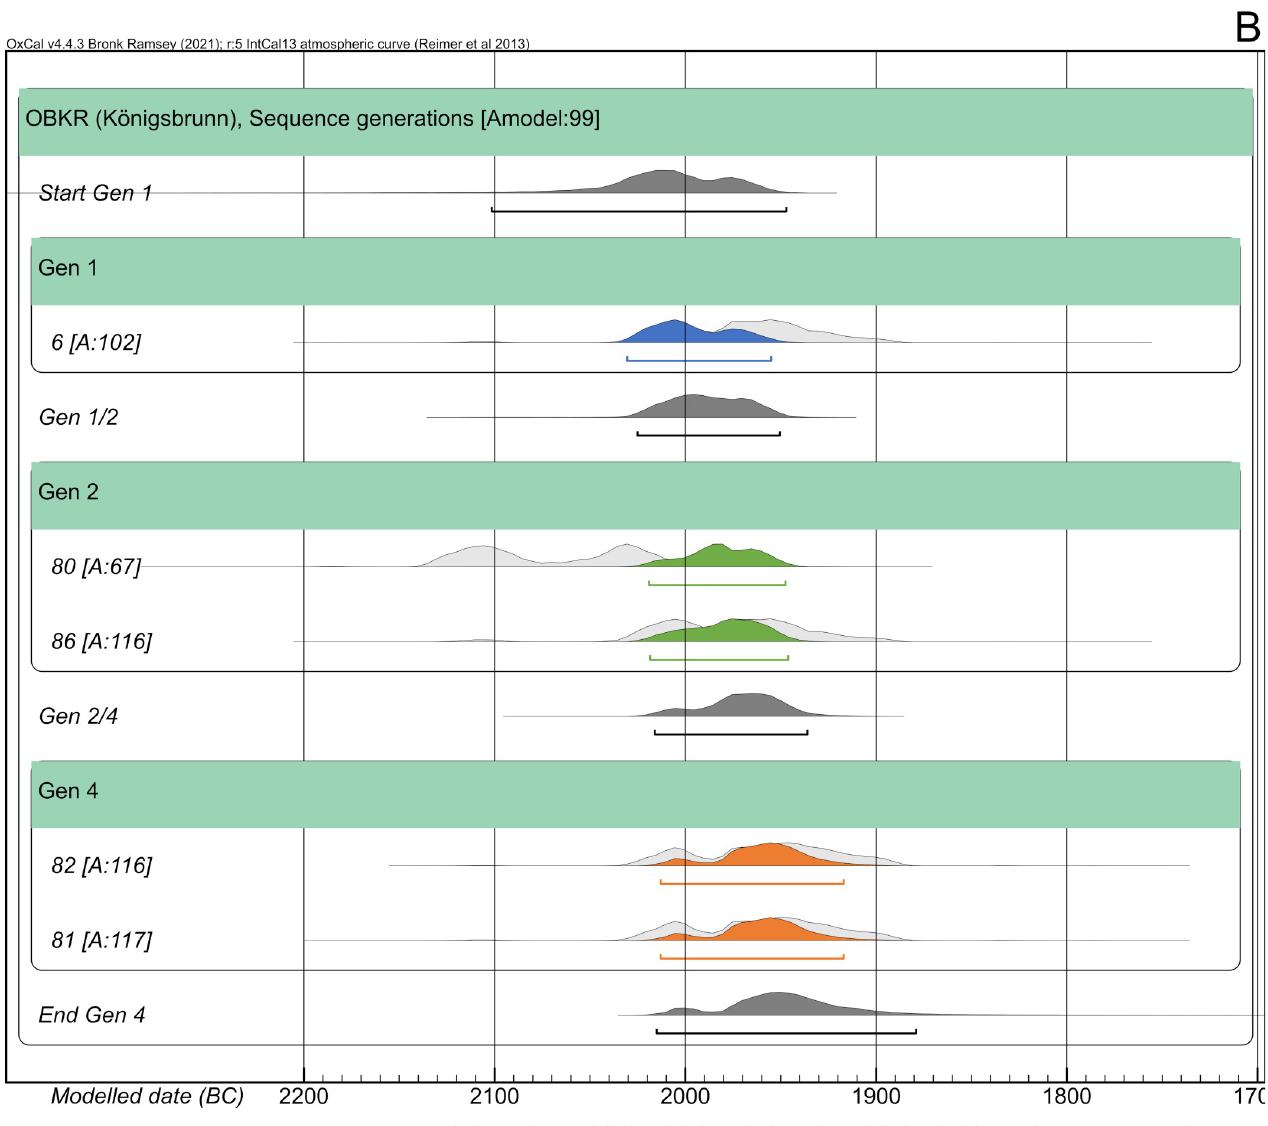
Fig 21. Bayesian modelling of the pedigree of OBKR. (light grey) unmodelled probabilities; (coloured) modelled probabilities. The process was run by directly sequencing the generations and ignoring the gap in the 3 rd generation (see S7 Table Sheet 1).